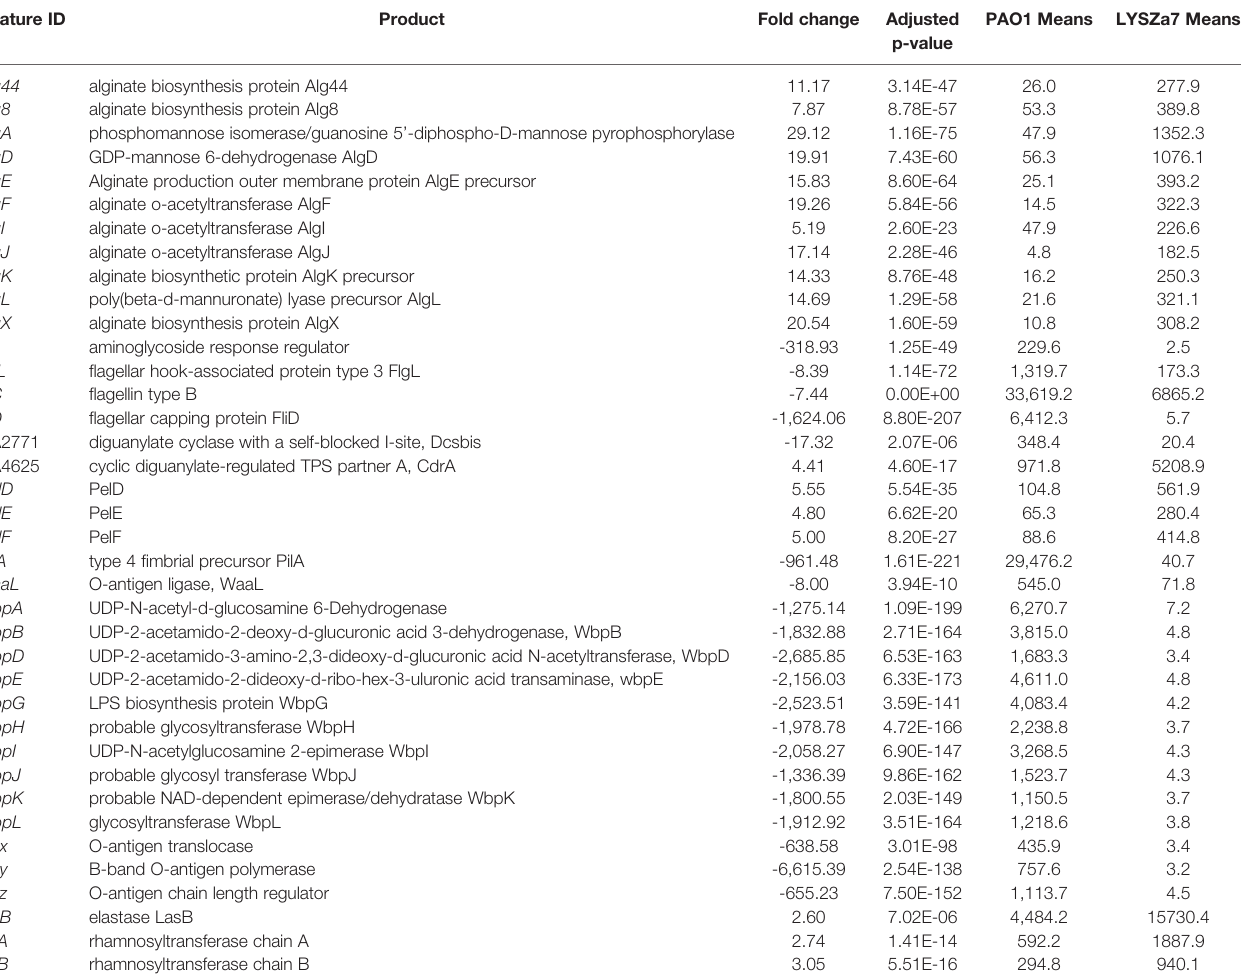
TABLE 3 | Signi fi cantly regulated genes involved in virulence and bio fi lm formation in LYSZa7 comparing to P. aeruginosa PAO1 (fold change ≧ 2, FDR adjusted p-value < 0.05); means: normalized mean counts of the sample groups. Feature ID Product Fold